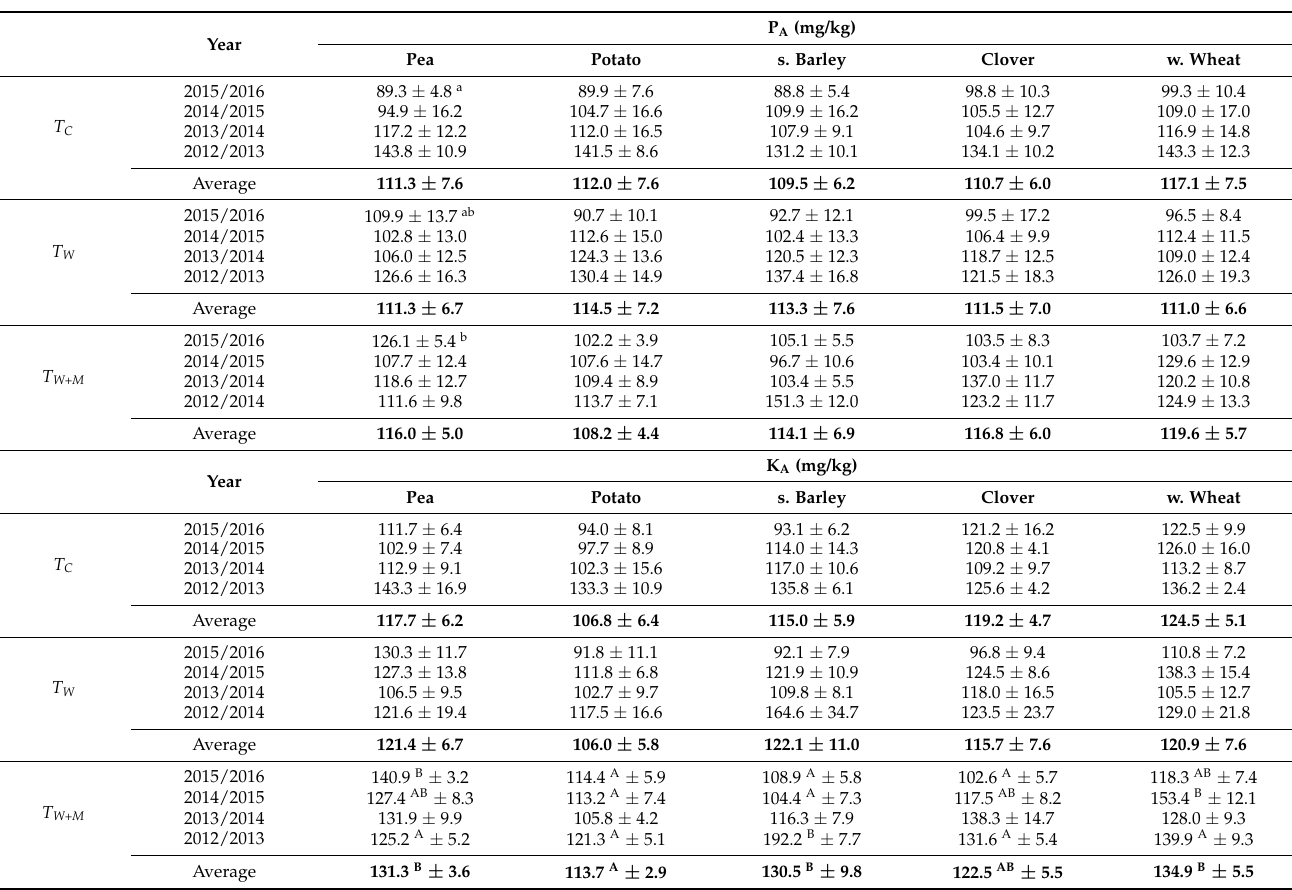
Table 7. The average plant-available phosphorous (P A ) and potassium (K A ) content (mg/kg) and their standard error (SE) of mean within the topsoil by crops, winter cover crop management systems and